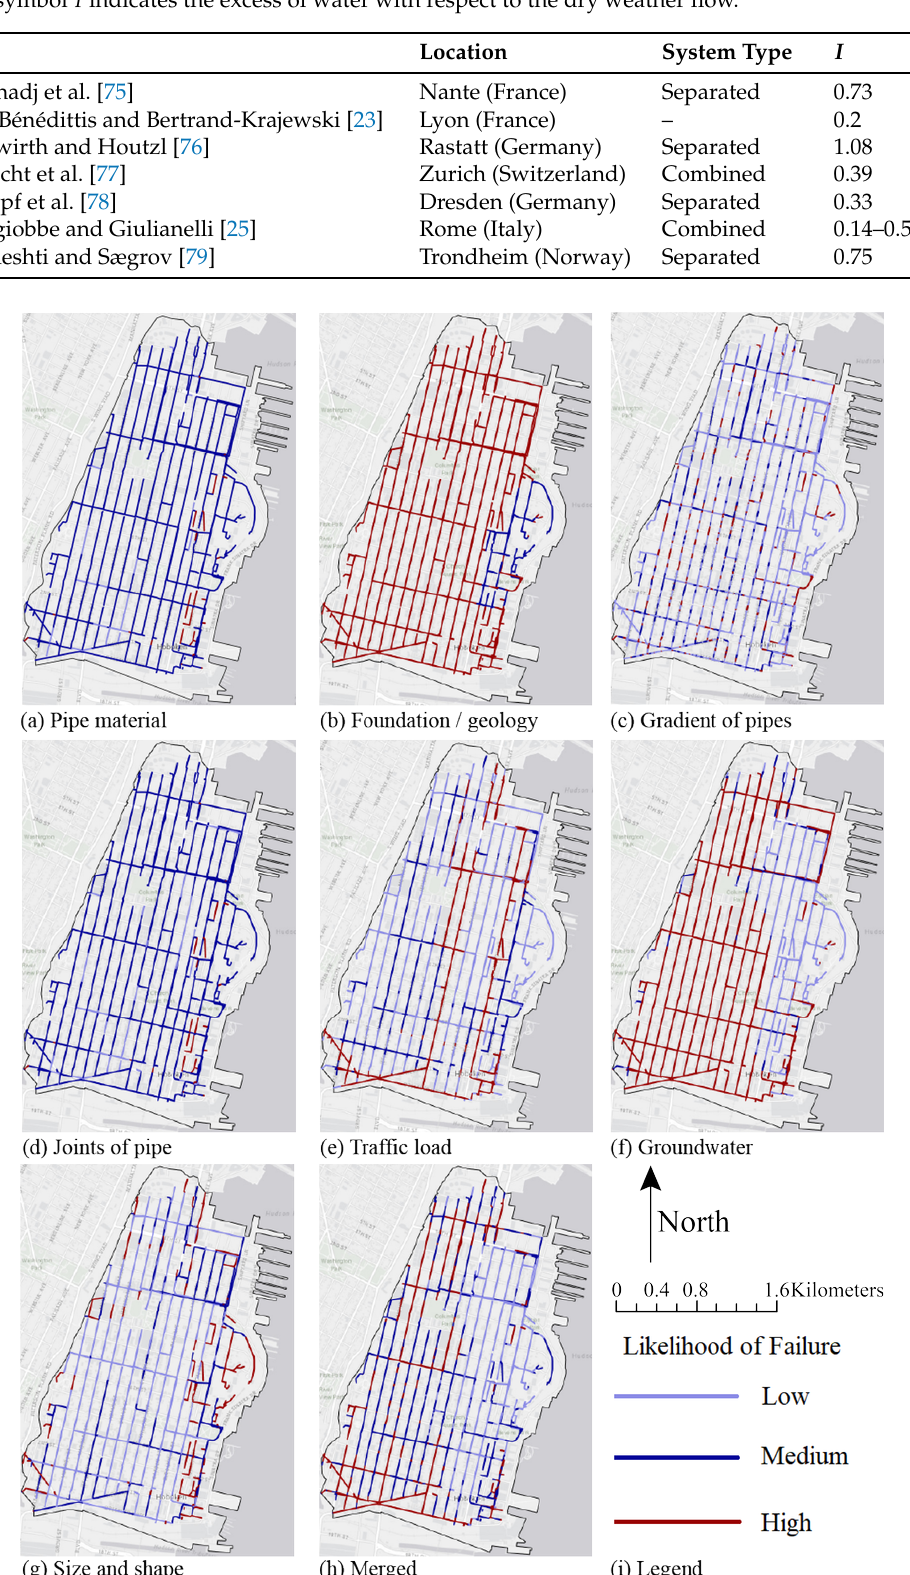
Table 2. Summary of previous works where infiltration into a sewer network was quantified. The symbol I indicates the excess of water with respect to the dry weather flow.